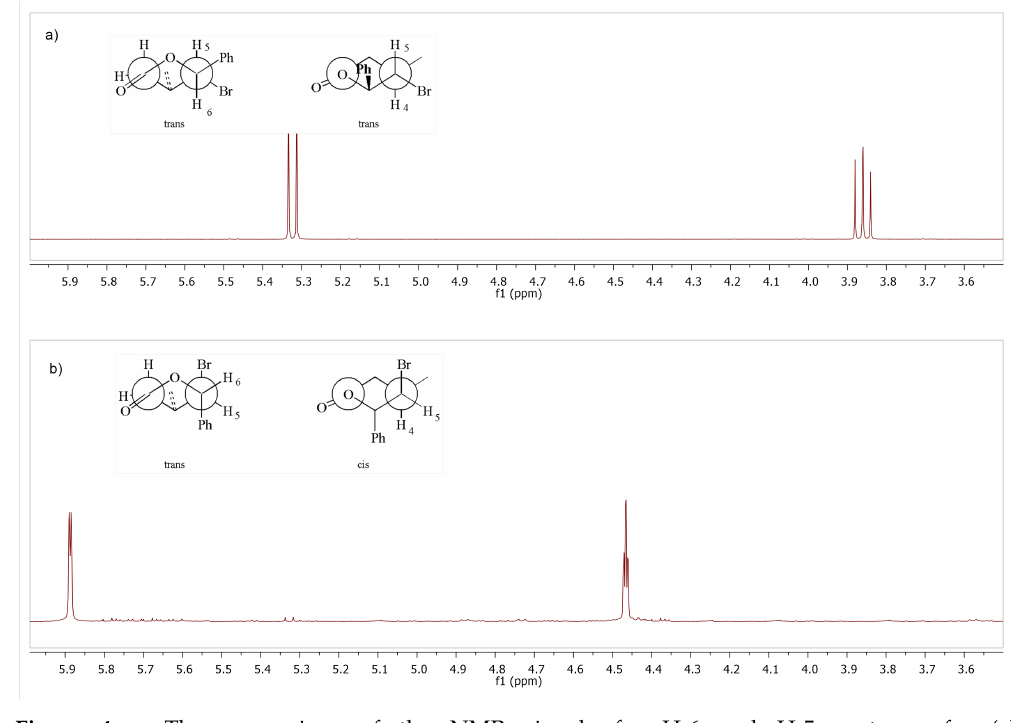
Figure 4. The comparison of the NMR signals for H-6 and H-5 protons of: ( a ) trans,trans - γ -bromo- δ -lactone 7b and ( b ) cis,trans - γ -bromo- δ -lactone 8b